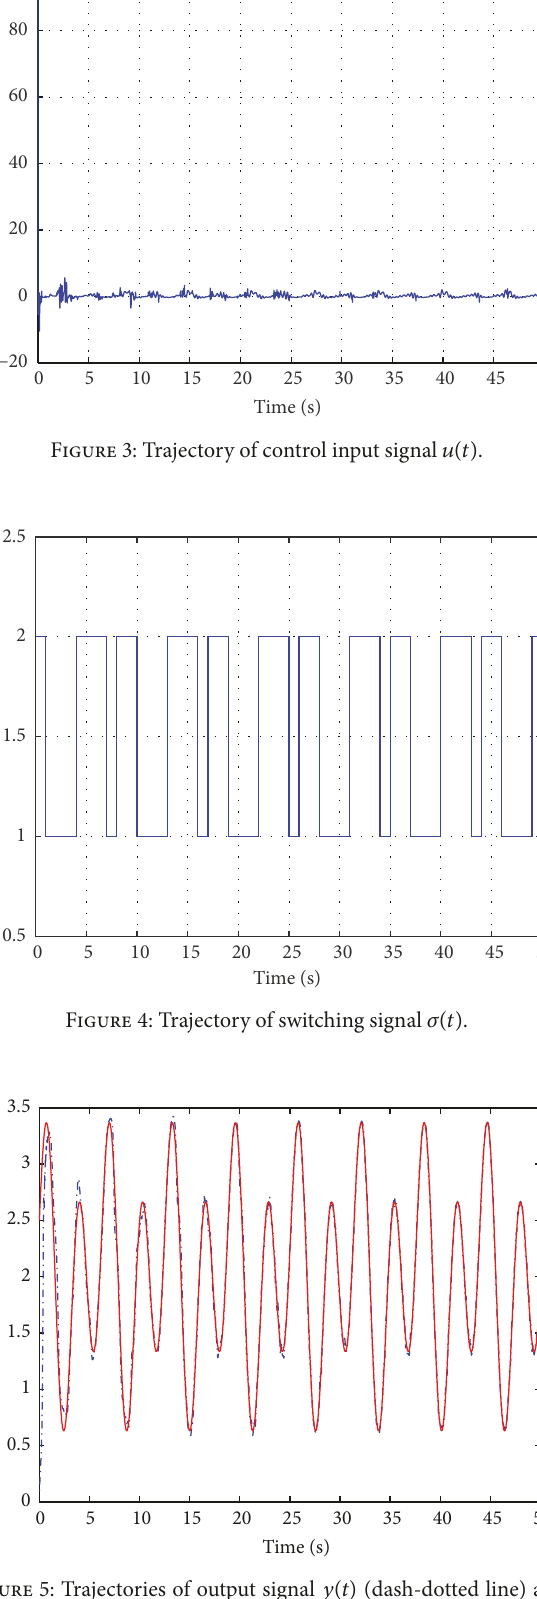
Figure 5: Trajectories of output signal 𝑦(𝑡) (dash-dotted line) and reference signal 𝑦 𝑟 (𝑡) (solid line) using method